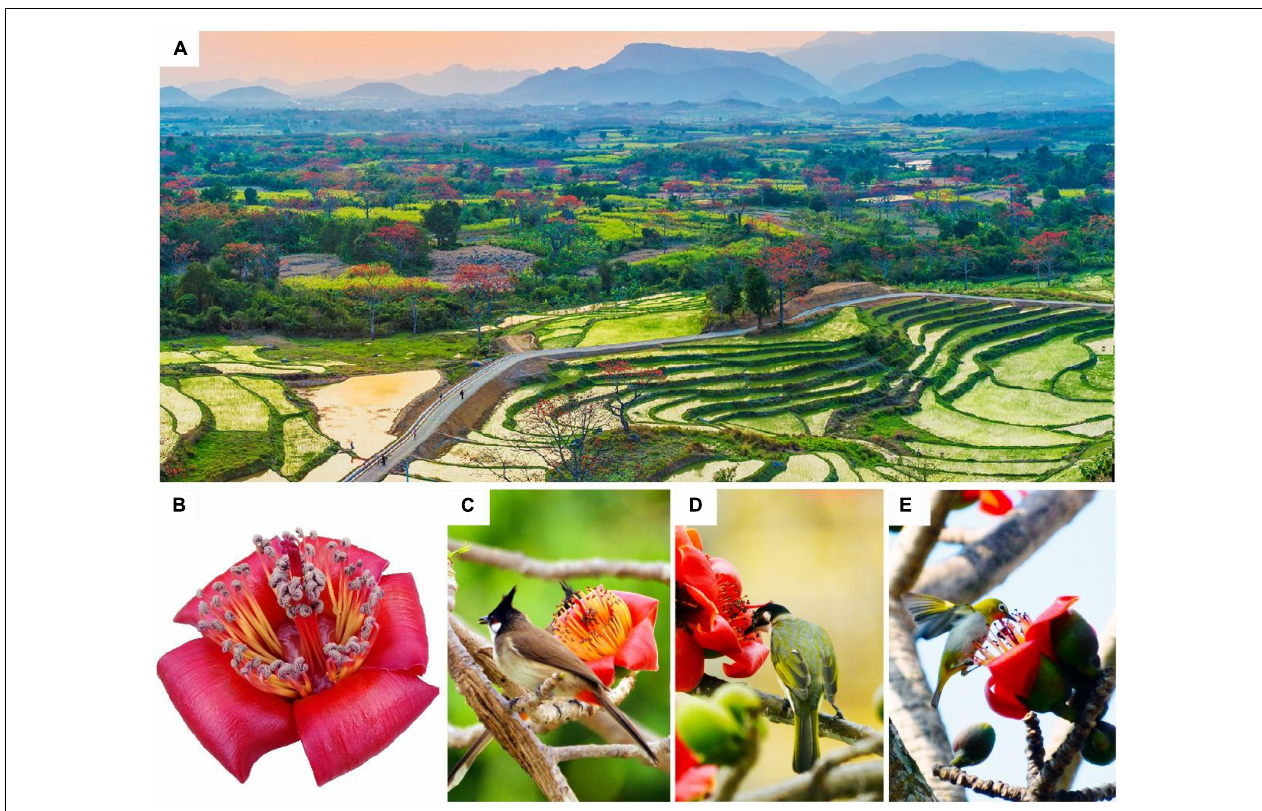
FIGURE 1 | Bombax ceiba ( B. ceiba ) in Hainan Island. (A) A flowering population in west Hainan Island. (B) A representative picture of floral syndromes. Note that stamens are in two whorls. B. ceiba flowers were mainly visited by Pycnonotus jocosus (C) , Brachypodius atriceps , (D) and Zosterops palpebrosus (E) . TABLE 1 | The different types of birds that visit Bombax ceiba as well as their frequency of visits, habits, and flight capability. Species Group Visit frequency Long distance flight Home range impacts members (Visits*tree − 1 *h − 1 ) capability ( > 5 km) on axial